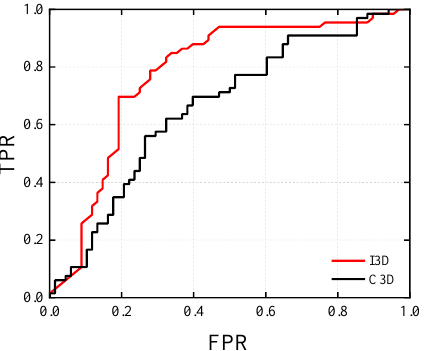
Figure 7. Pixel-level ROC curves with video feature extraction method changes.